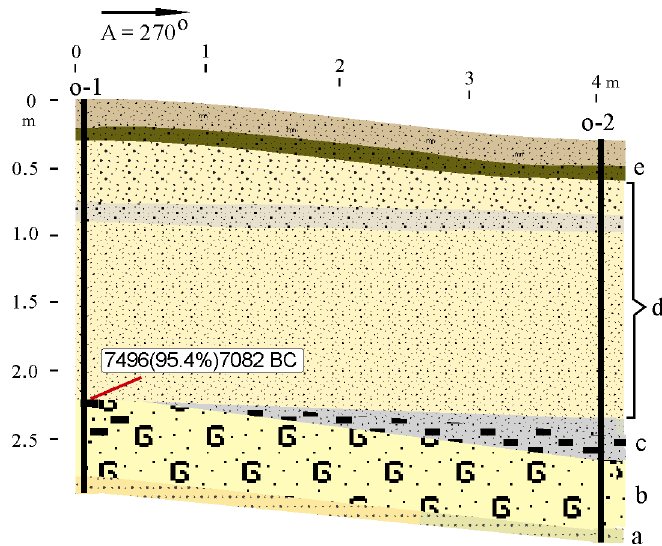
Fig. 6. Geological structure of the proximal part of the J3 valley cone: a, fluvioglacial sediments of the ground; b, gyttja; c, sandy peat; d, sand and gravel deposits; e, sand and silt